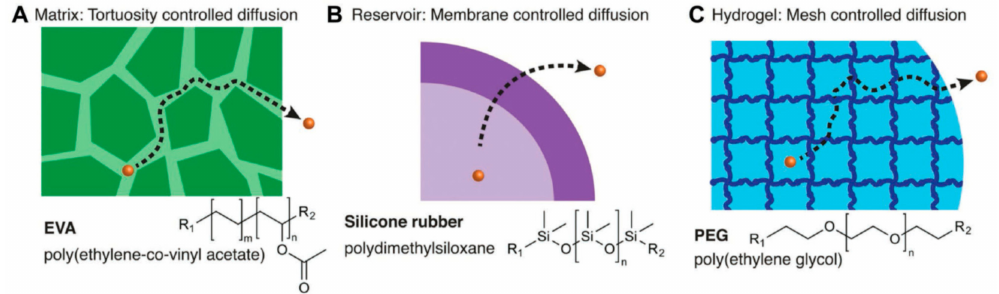
Figure 6. Examples of controlled release platforms. ( A ) Matrix tortuosity-controlled diffusion; ( B ) Membrane-controlled diffusion; ( C ) Hydrogels [62]. Copyright 2018 John Wiley and Sons.